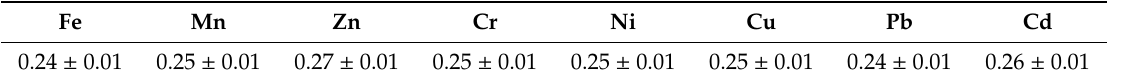
Table 2. Wash-o ff rate constant (W) for 8 heavy